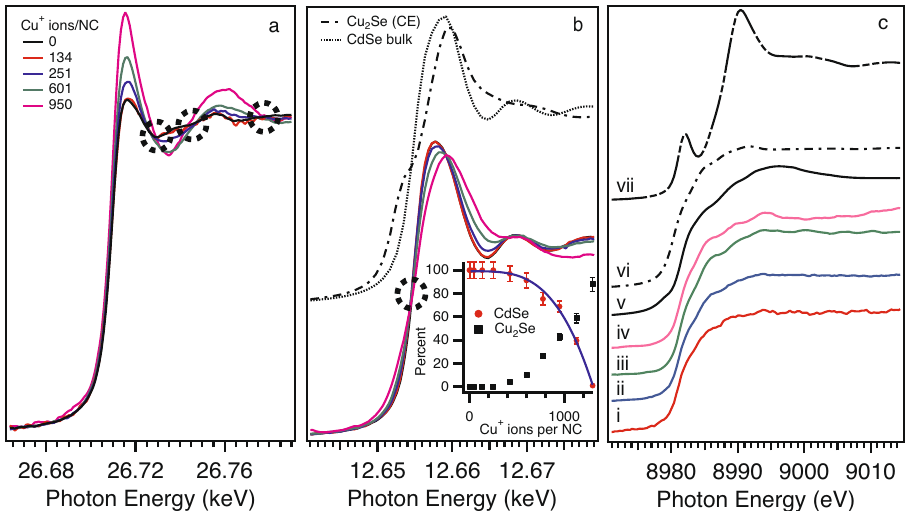
Fig. 1 Core level XANES during the cation exchange reaction. X-ray absorption spectra for 5.0 nm CdSe NCs at the ( a ) Cd K-edge, ( b ) Se K-edge, and ( c ) Cu K-edge for (i) 134, (ii) 251, (iii) 601, (iv) 950 Cu ions/NC, (v) Cu 2 Se via cation exchange of CdSe, (vi) commercial Cu 2 Se, and (vii) Cu(I)PF 6 . The inset of ( b ) are the LCF results for the Se K-edge using a CdSe and Cu 2 Se model. The error bars in the inset represent uncertainties in the LCF.